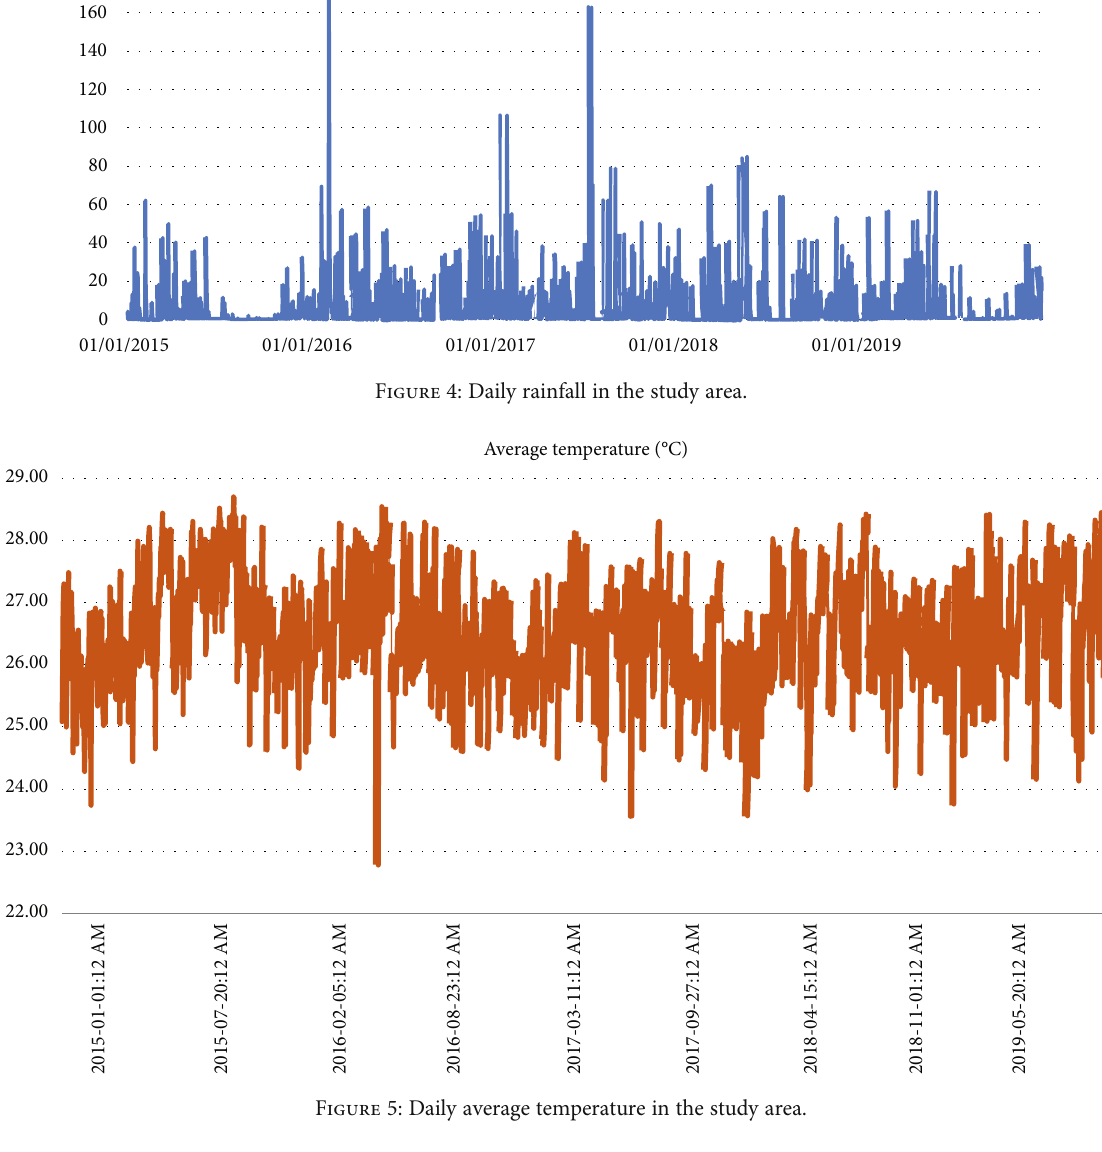
Figure 5: Daily average temperature in the study